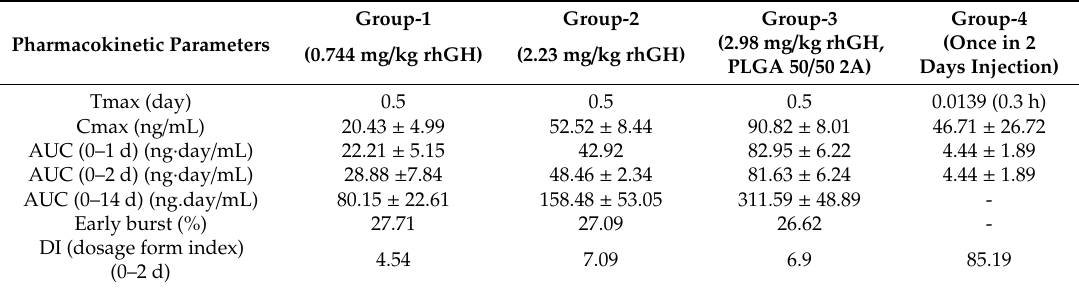
Table 1. Pharmakokinetic studies on group-1 (0.744 mg/kg rhGH), group-2 (2.23 mg/kg rhGH),